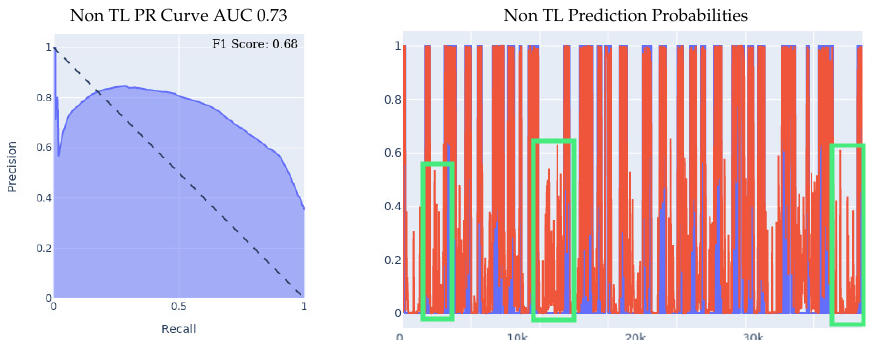
Figure 9. 70/30 Train/Test Data Split Experiment for MSBAND to Huawei. For prediction proba- bilities, the x axis is the time, the y axis is the prediction threshold, blue data is the real labels, and red data is the prediction probabilities. The green box highlights the areas which contribute to the greatest differences between the two models.